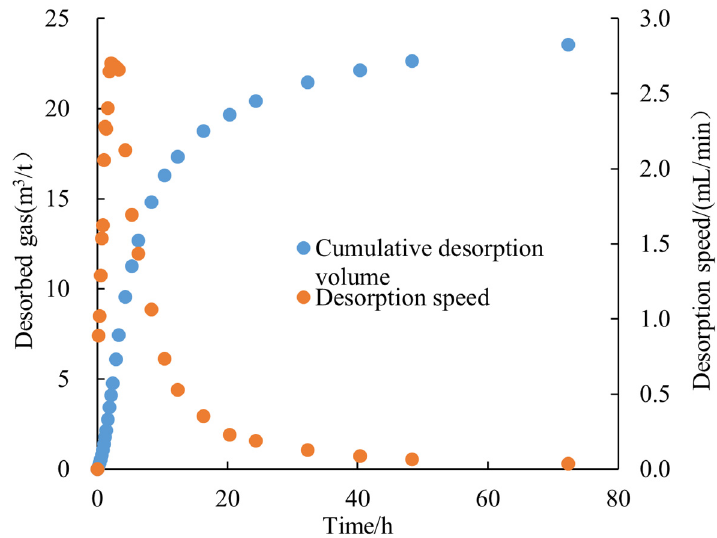
Figure 4. Desorption Curve of Sample P1.